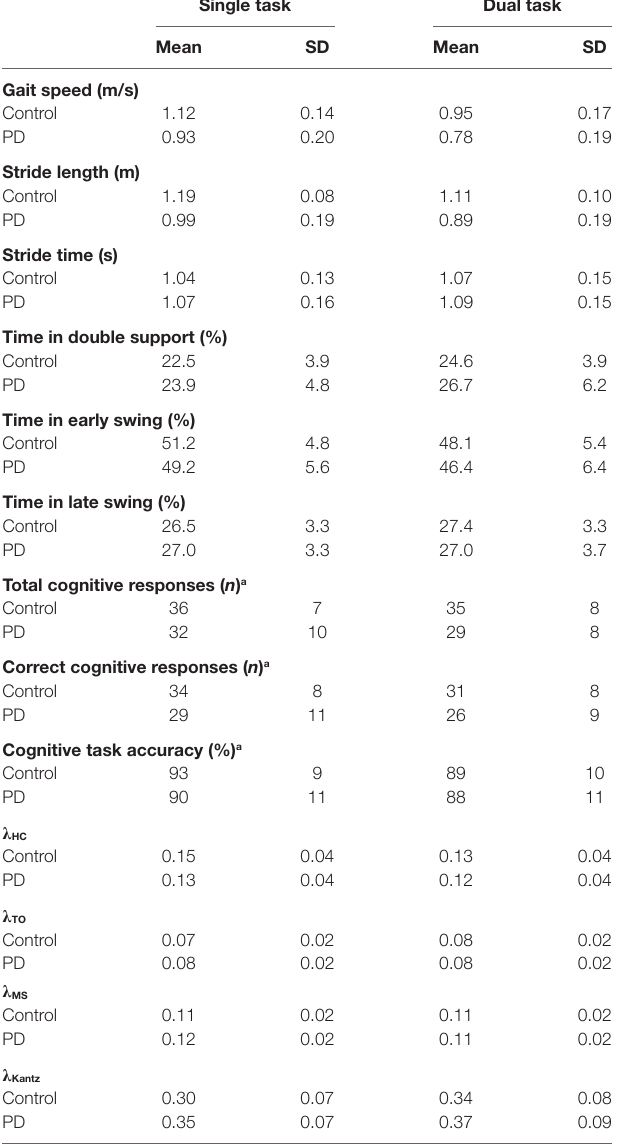
Table 2 | Univariate means (SD) of each outcome stratified by group and